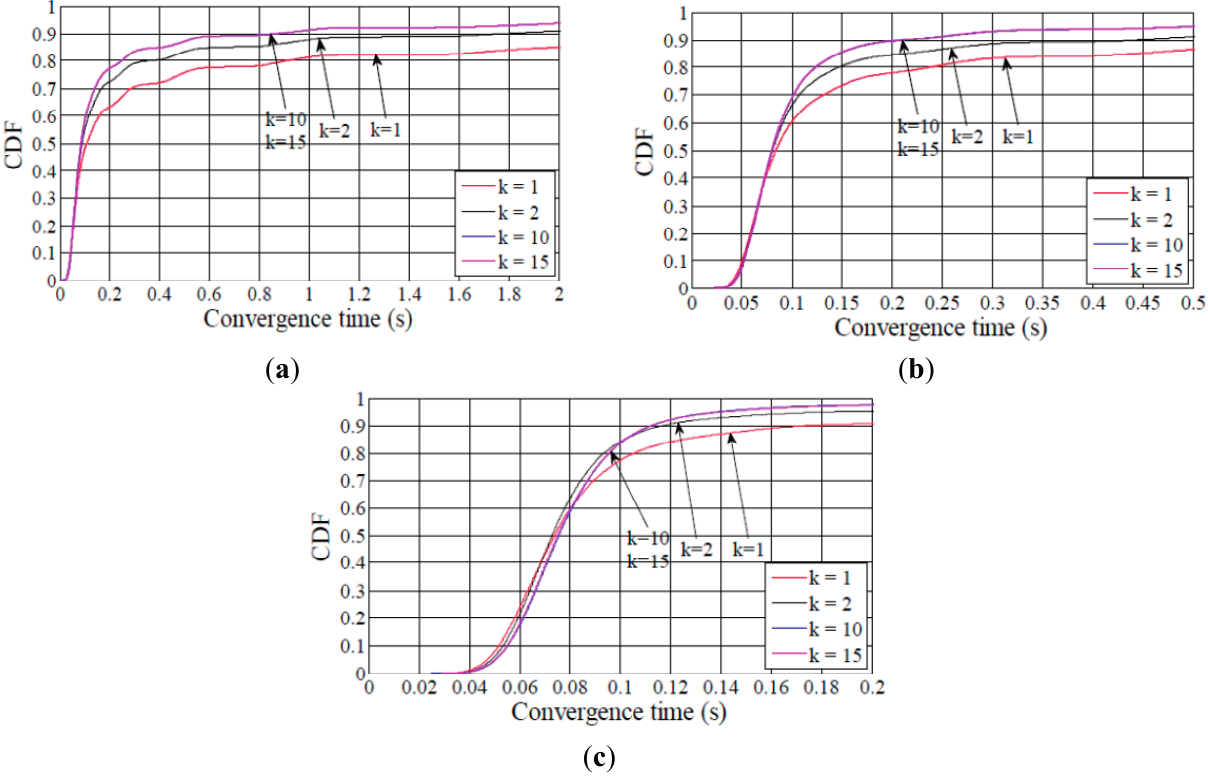
Figure 5. CDF of network convergence time in the small network size scenario. The average node degrees are 5, 10 and 15 in figures ( a ), ( b ) and ( c ), respectively.